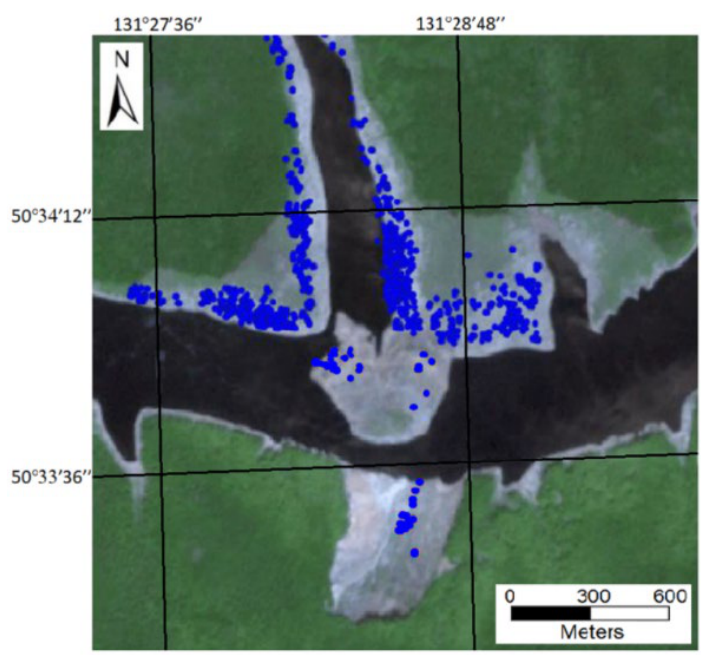
Figure 6. Distribution of PS-like points in the landslide area (courtesy of [46]).